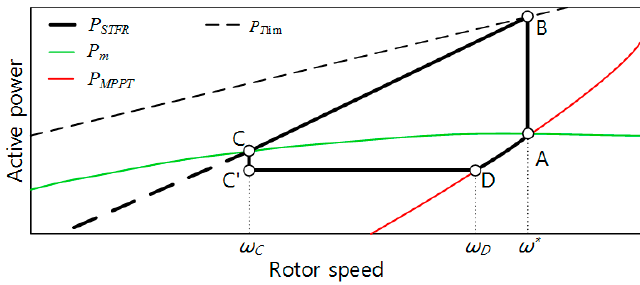
Figure 3. P STFR for Scheme #2 [14]. P STFR : power reference of Scheme #2; ω C , ω D : rotor speeds at Point C and Point D.